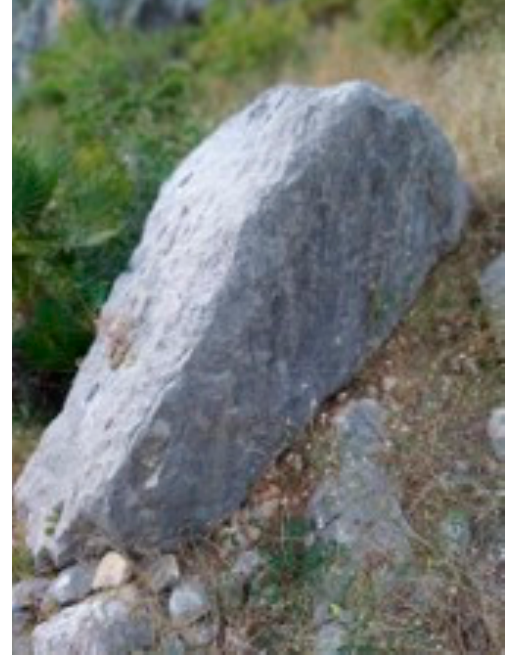
Figure 9. Under the prayer, there is a stone for the rituals. The photo is taken by the author.